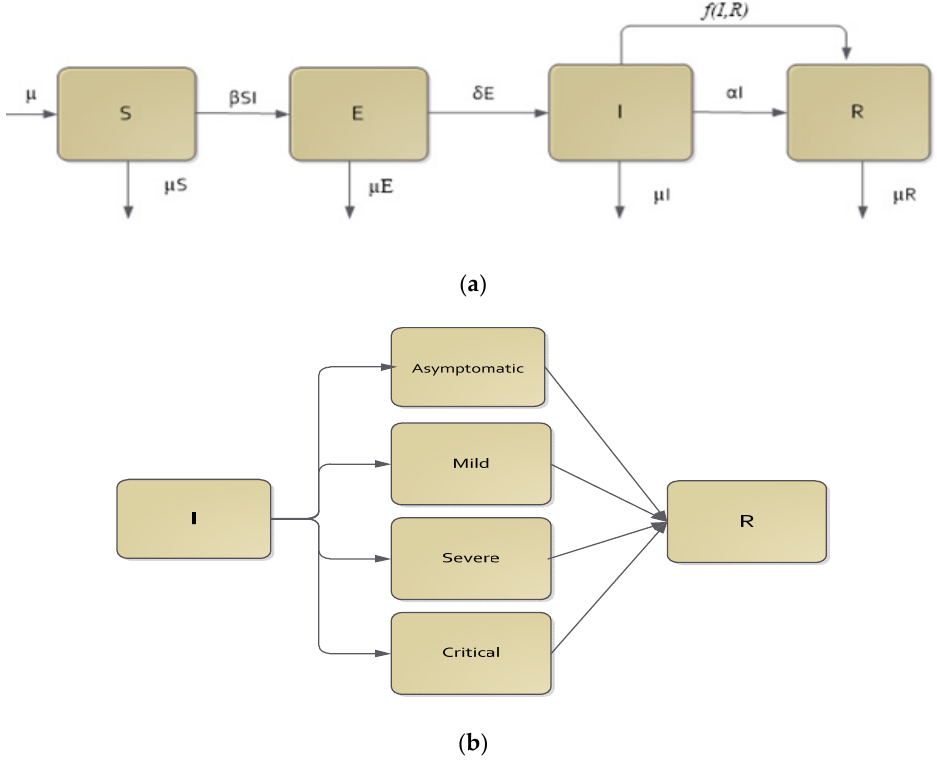
Figure 1. Progression diagram of SEIR transmission with CPT effect f ( I ( t ), R ( t )) ( a ) and four possible severity levels of COVID-19 infected patients ( b ).